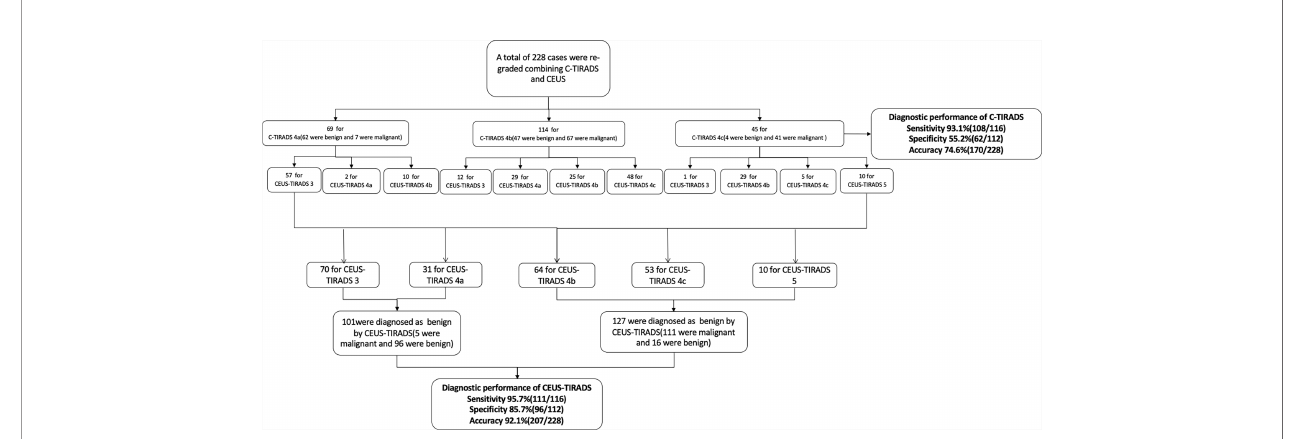
FIGURE 5 | The process of establishing of CEUS-TIRADS model.